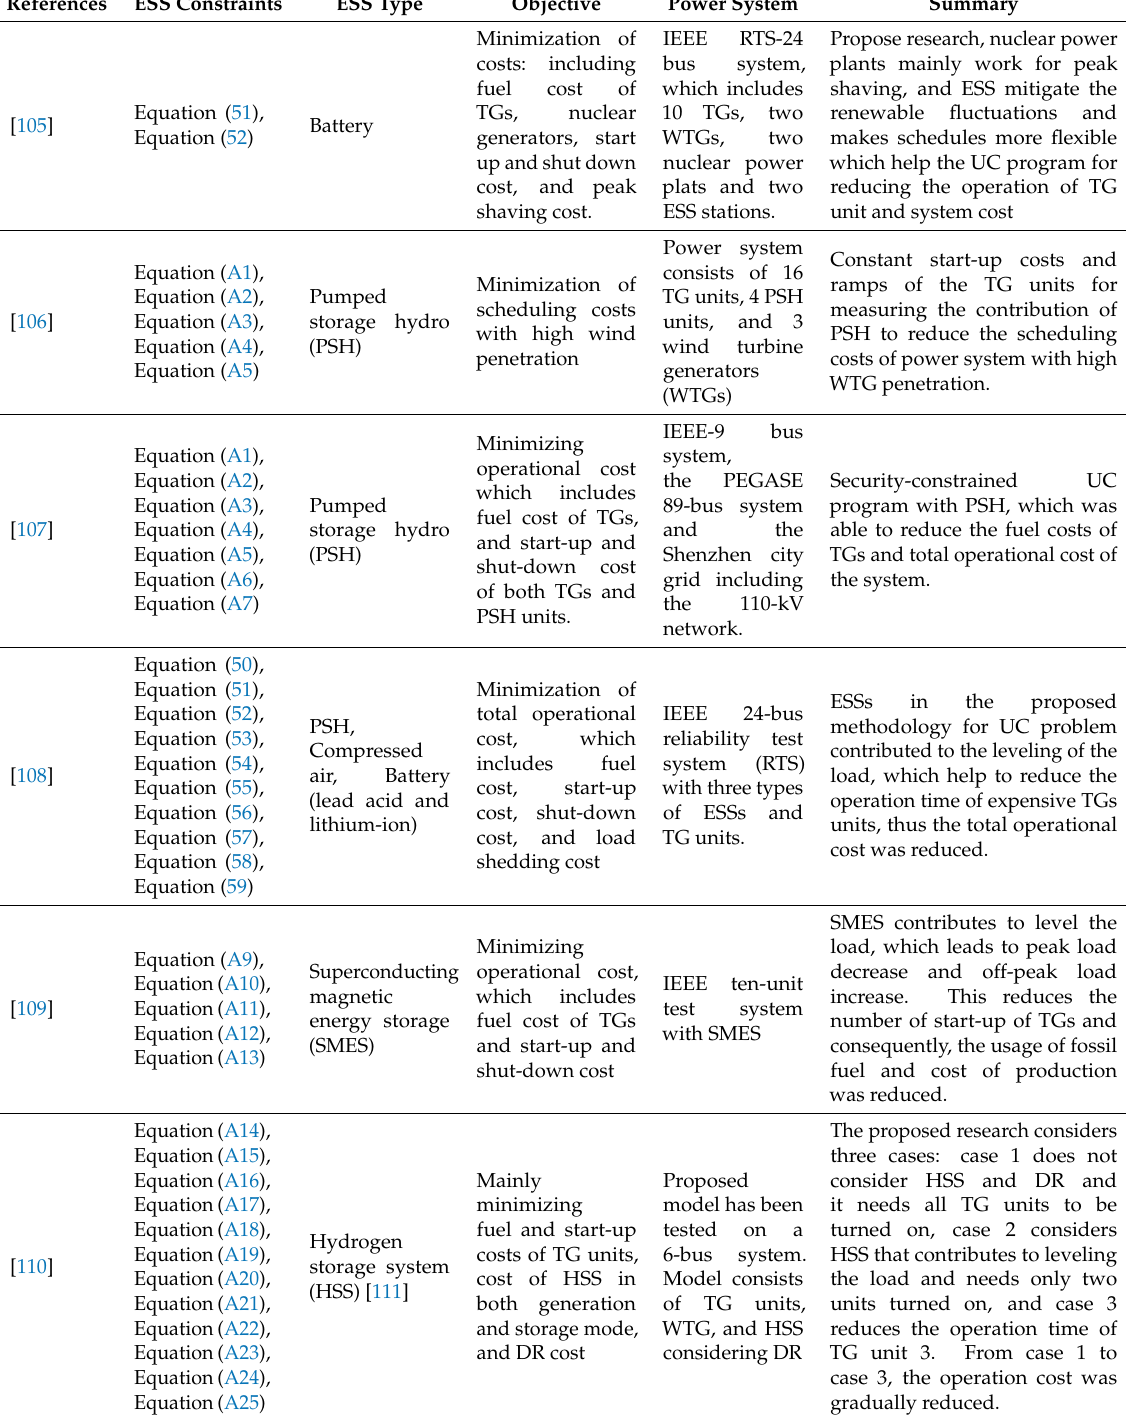
Table 2. ESS contribution in unit commitment (UC) with